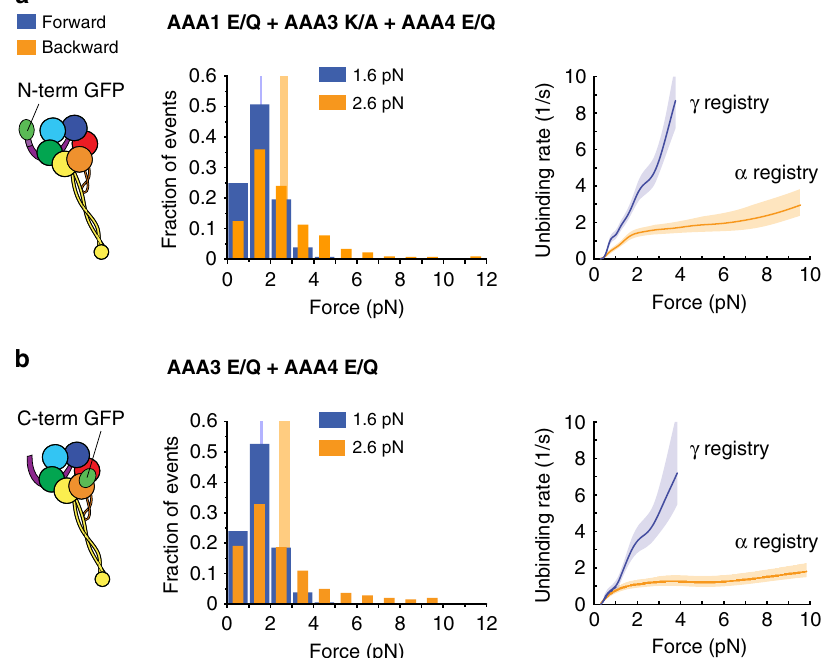
Fig. 6 ATP binding to AAA4 is not suf fi cient to overcome the AAA3-induced block on AAA1. a Schematic of dynein with GFP fused to the N-terminus (left). Histogram of forward (blue) and backward (orange) unbinding forces for the AAA1 E/Q + AAA3 K/A + AAA4 E/Q-GFP-Dyn1 331kDa triple mutant measured under N-terminal tension in the presence of 1 mM ATP (middle). The respective mean values are noted. The vertical bands represent 95% CIs for the means (forward: [1.5, 1.6] pN, backward [2.4, 2.8] pN). (Right) Unbinding rate vs. force derived from the data on the left. The shaded areas are 95% CIs for the mean rates, which were estimated by bootstrapping. b Same as in a , but for the AAA3 E/Q + AAA4 E/Q-Dyn1 331kDa -GFP double mutant measured under C-terminal tension (95% CIs [1.5, 1.7] and [2.4, 3] pN). The number of events in the forward and backward directions: ( a ) (546,451) and ( b ) (279, 234). Source data are provided as a Source Data fi le. the β registry in the presence of ATP while WT dynein with an N- switch between different registrations depending on the nucleotide terminal GFP shows an unbinding behavior that re fl ects transitions state of AAA1 and AAA3 (i.e., when tension is applied via the N- through different stalk registrations 42 (Table 1), this suggests that terminal linker) (Figs. 4 and 5). Together with our previous work that demonstrated that WT dynein with a C-terminal GFP assumes tension applied via the linker facilitates the motor ’ s progression NATURE COMMUNICATIONS| (2020) 11:5952